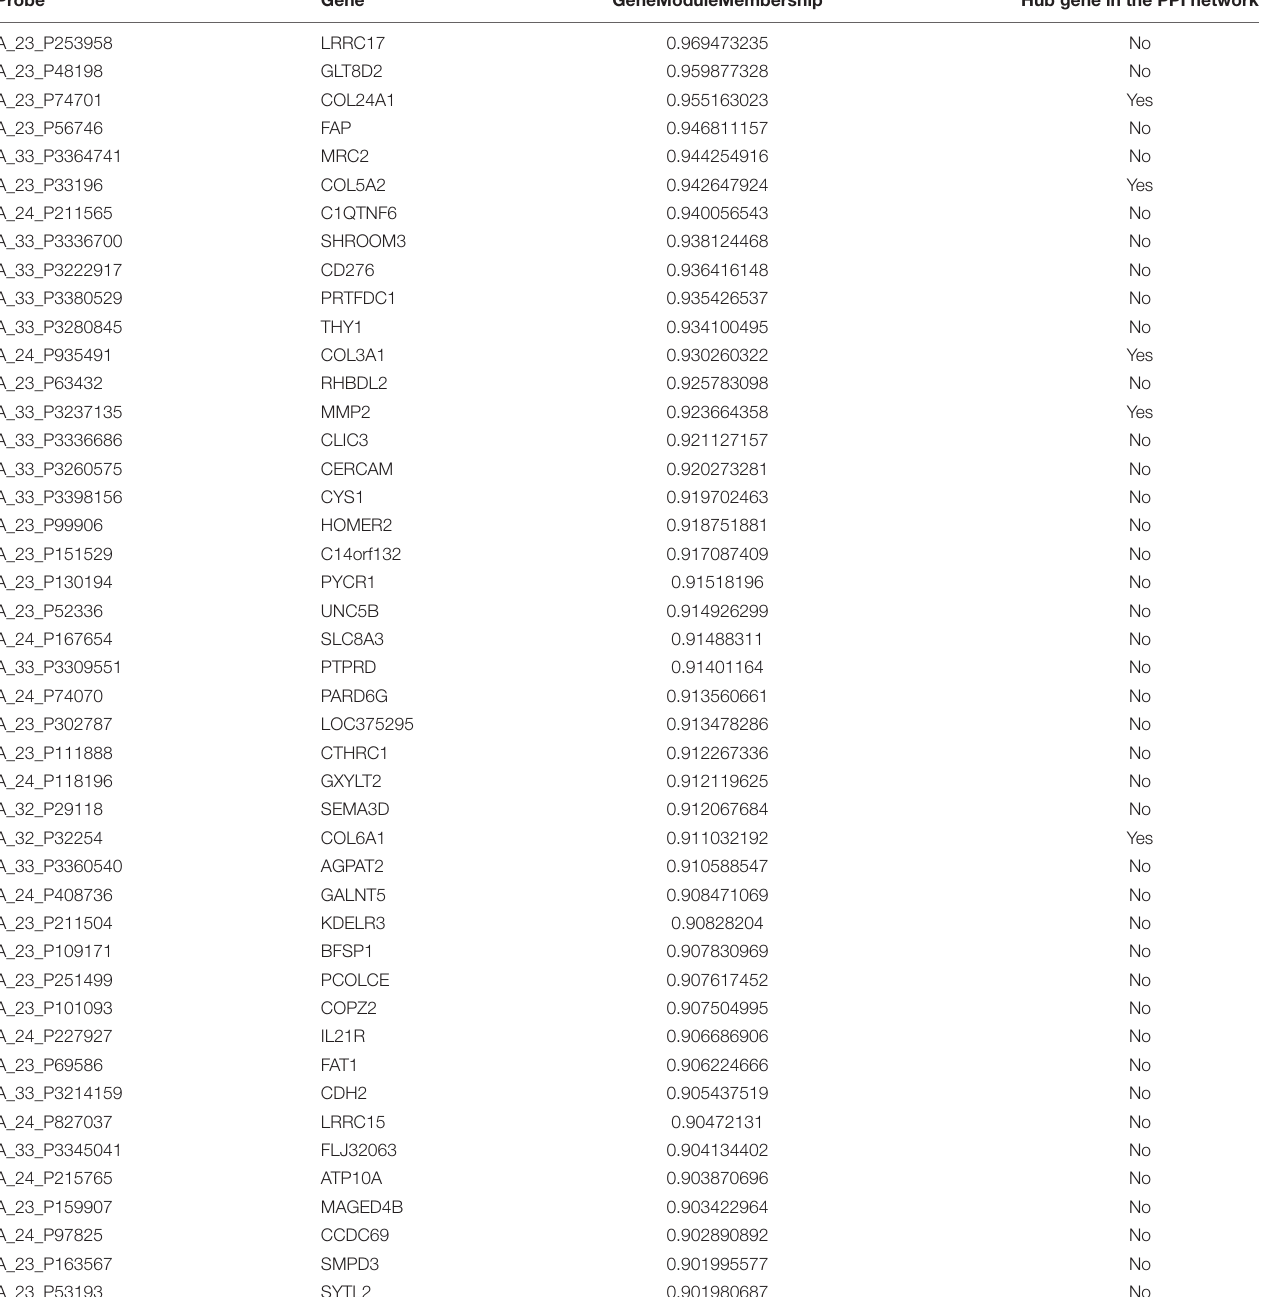
TABLE 1 | Hub genes from the yellow module. Probe Gene GeneModuleMembership Hub gene in the PPI